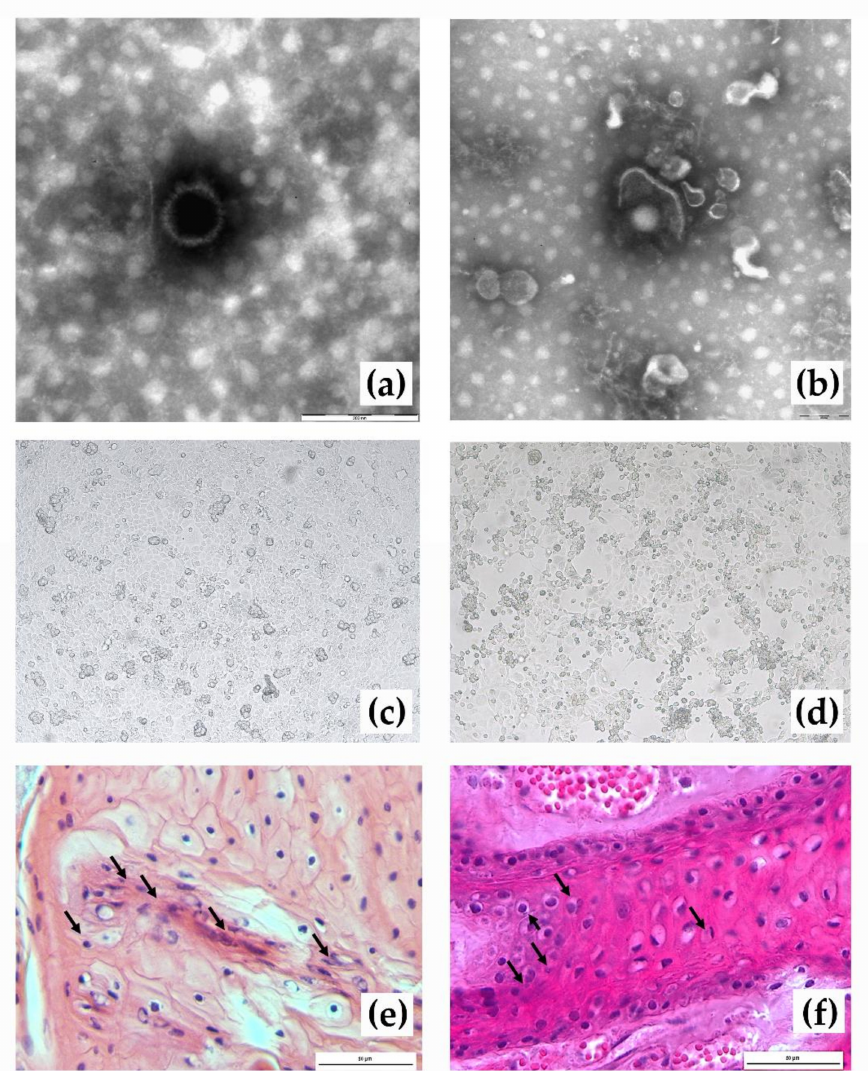
Figure 4. Electron micrograph of an isolated capsid of herpesvirus virion (bar = 200nm) ( a ) and of a full particle showing the envelope partially fragmented (bar 300 nm) ( b ) 2% NaPT staining; virus isolation on RK-13-KY cells with non-infected RK-13-KY cell monolayer (control) ( c ) and cytopathic effect observed in RK-13-KY cells infected with Equid gammaherpesvirus 7 at 100 × magnification ( d ); the haematoxylin and eosin staining of the epithelium shows lympho-granulocyte inflammatory infiltrates ( e ). Eosinophilic inclusions ( f ) are observed in some cells. Images were taken at 40x magnification, and the bar represents 50 µ